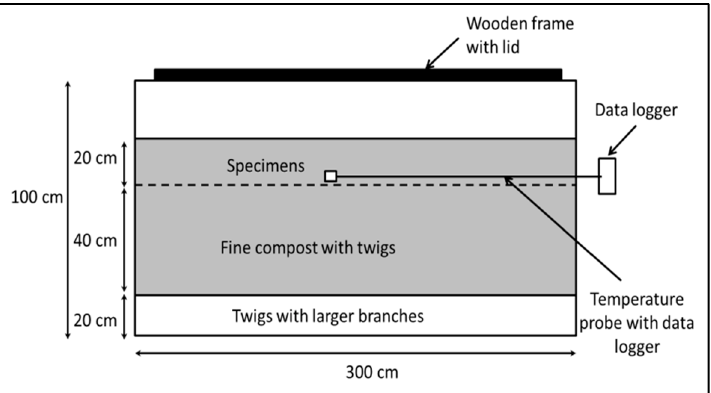
Figure 2. Schematic diagram of the compost pile used for the biodegradability test [19].